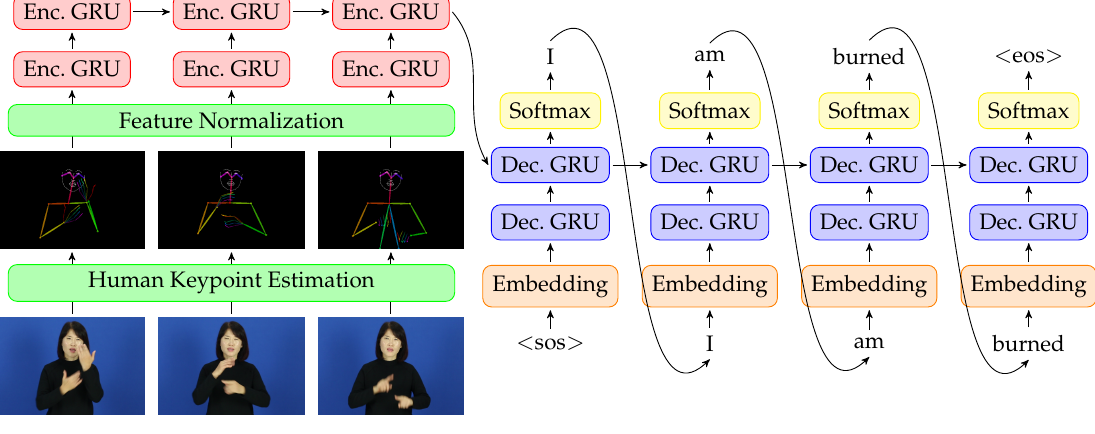
Figure 4. An overall architecture of our approach that translates a sign language video into a natural language sentence using sequence to sequence model based on GRU